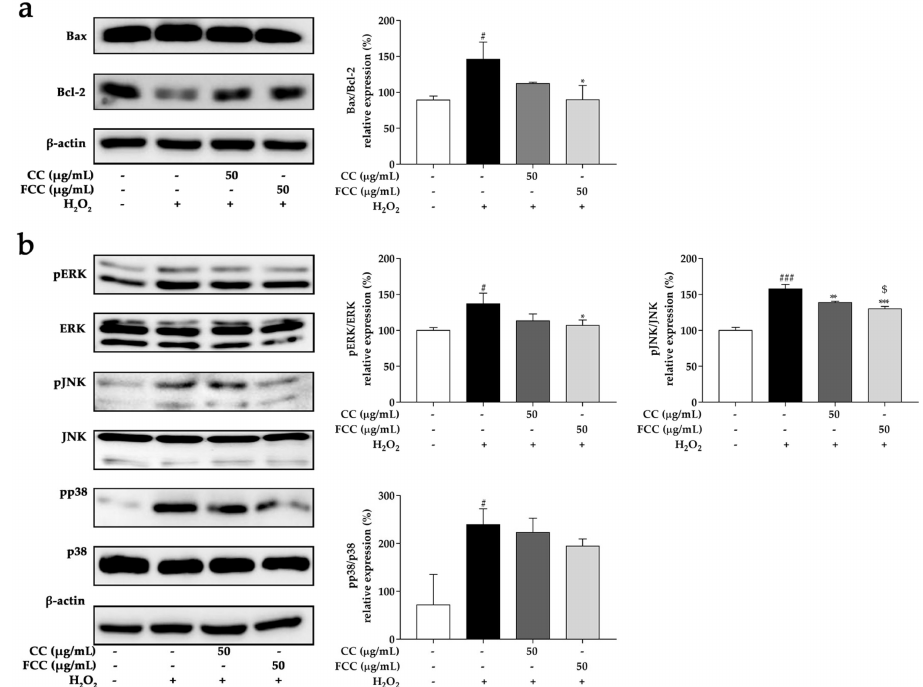
Figure 7. E ff ect of CC or FCC (50 µ g / mL) on Bax and Bcl-2 family protein, and MAPK (ERK, JNK, and p38) protein expression in SH-SY5Y neuroblastoma cells. Cells were pretreated with CC or FCC (50 µ g / mL) for 2 h, followed by co-treatment with H 2 O 2 for another 24 h. ( a ) Bax and Bcl-2 family protein, and ( b ) phosphorylation MAPK protein expression levels were evaluated by western blotting. “ + , -”: Cells were treated with or without CC, FCC or H 2 O 2 . The data are expressed as mean ± SD, n = 3. # p < 0.05, ### p < 0.001, compared to the control group and * p < 0.05, ** p < 0.01, *** p <